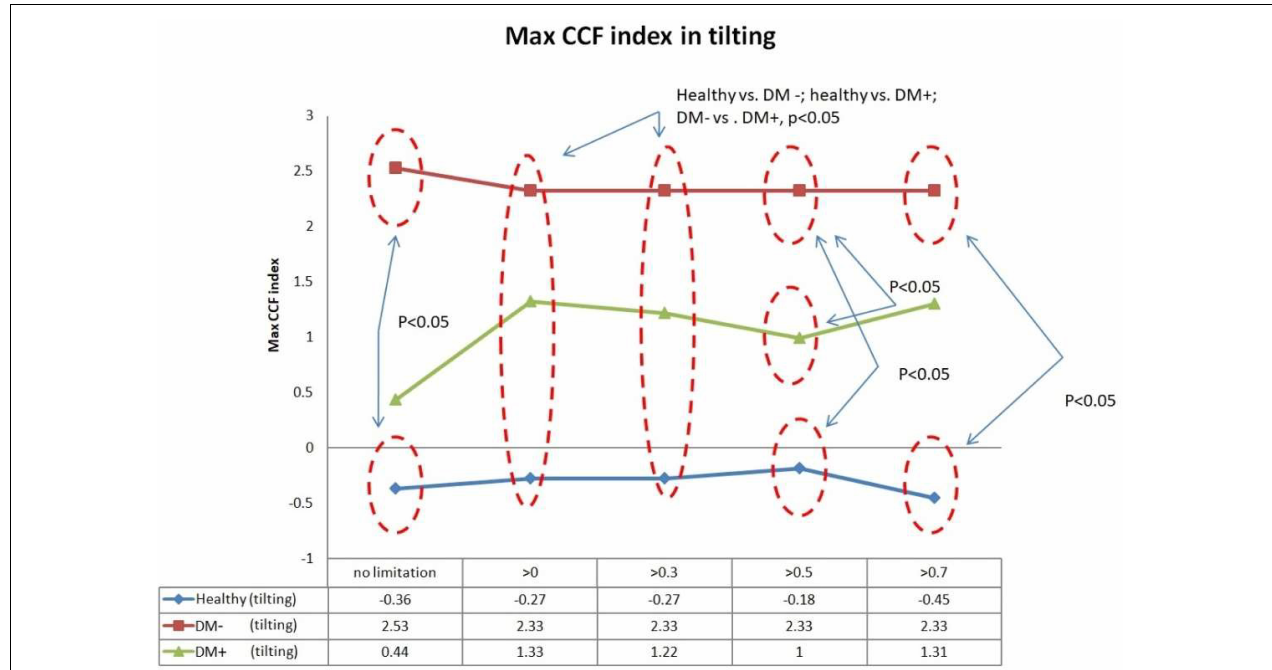
FIGURE 10 | The plot of the maximum CCF index with different thresholds by ACCF results in a tilting position. ACCF phase analysis during tilt. Filtered maximum CCF index in healthy (blue), diabetes mellitus (DM–, red), and DM with autonomic neuropathy (DM+, green). When the threshold setting was set greater than 0, 0.3, 0.5, and 0.7, the filtered maximum CCF index could significantly separate the healthy group from the DM– and DM+ groups ( p < 0.05). In addition, the two DM groups could be separated ( p < 0.05) when the threshold was set to 0, 0.3, and 0.5.